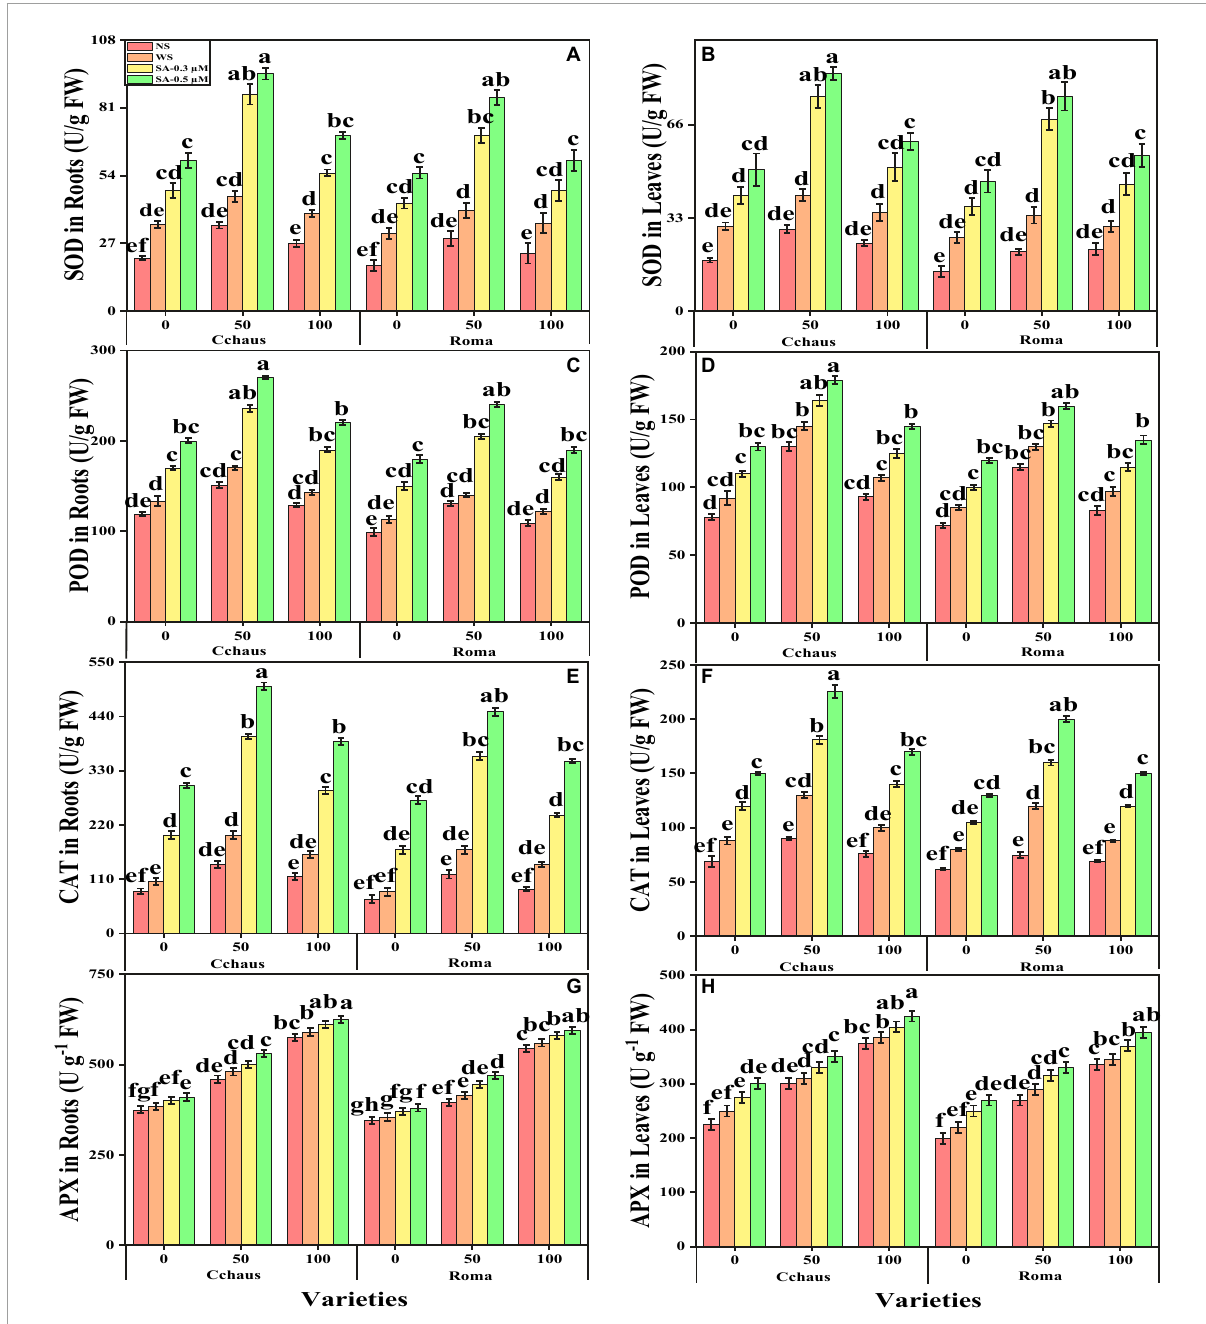
FIGURE4 Effect of exogenously applied syringic acid (0.3-0.5 ◦ µ M) on superoxide dismutase (SOD) activity in the roots (A) , SOD activity in the leaves (B) , peroxidase (POD) activity in the roots (C) , POD activity in the leaves (D) , CAT activity in the roots (E) , catalase (CAT) activity in the leaves (F) , ascorbate peroxidase (APX) activity in the roots (G) and APX activity in leaves (H) on Solanum lycopersicum varieties (Cchaus and Roma) cultivated under stress levels of Pb [0 (no Pb), 50 and 100 mg kg − 1 ]. Values are demonstrated as means of four replicates along with standard deviation (SD; n = 4). Two-way ANOVA was performed and means differences were tested by HSD ( P < 0.05) through Tukey’s test. Different lowercase letters on the error bars indicate significant difference between the